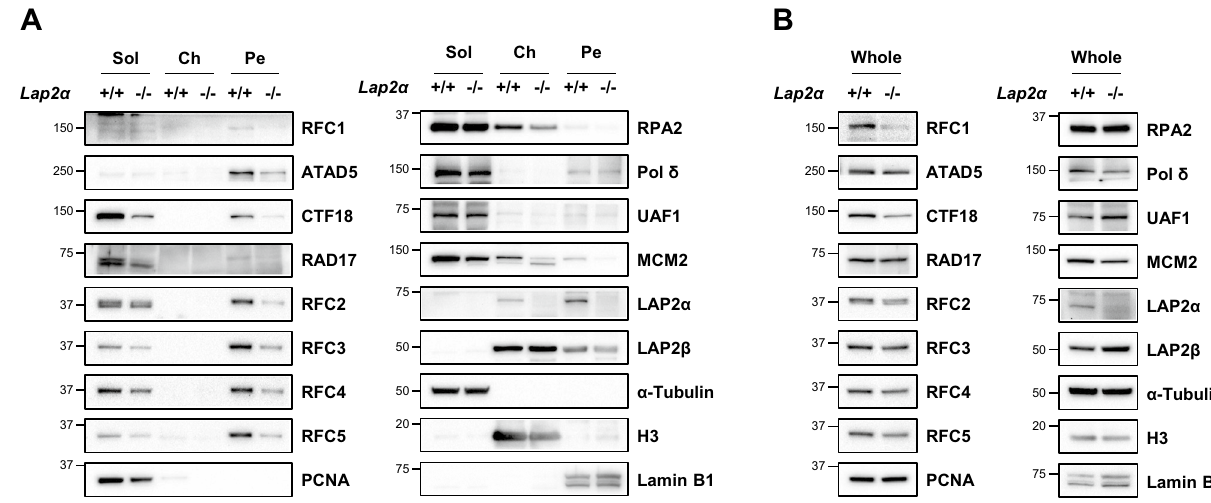
Figure 6. The association of RFC/RLC proteins with nuclease-resistant structures is reduced in Lap2α knockout cells. ( A ) Lap2α +/+ and Lap2α −/− mouse skin fibroblasts were fractionated and each fraction was subjected to immunoblotting. ( B ) Whole-cell extracts from Lap2α +/+ and Lap2α −/− mouse skin fibroblasts were subjected to immunoblotting. ( A , B ) Uncropped blot images are presented in Supplementary Fig.